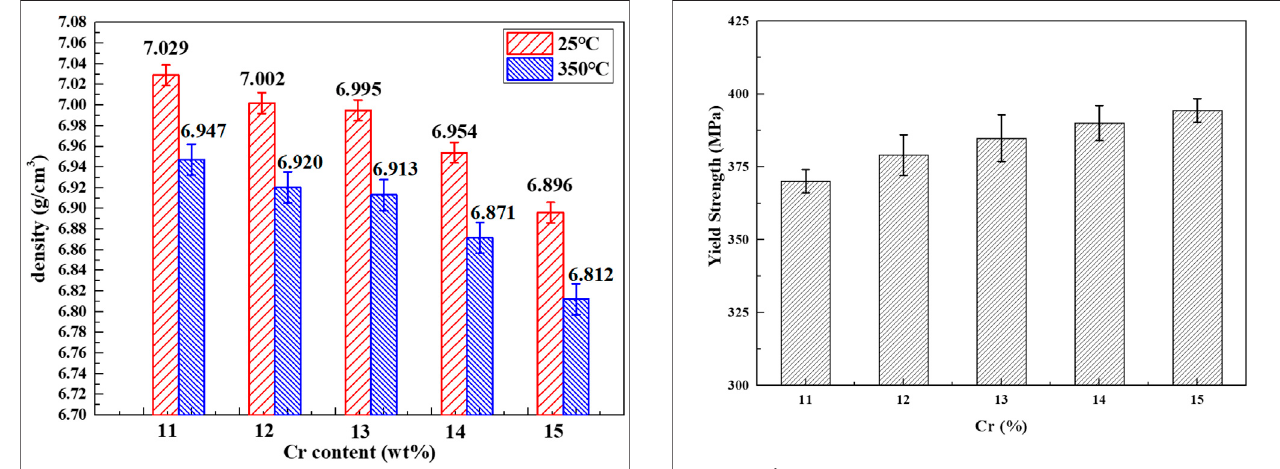
FIGURE 9 | Compressive yizeld strength of Fe – x Cr – 6Al alloys with different Cr content.